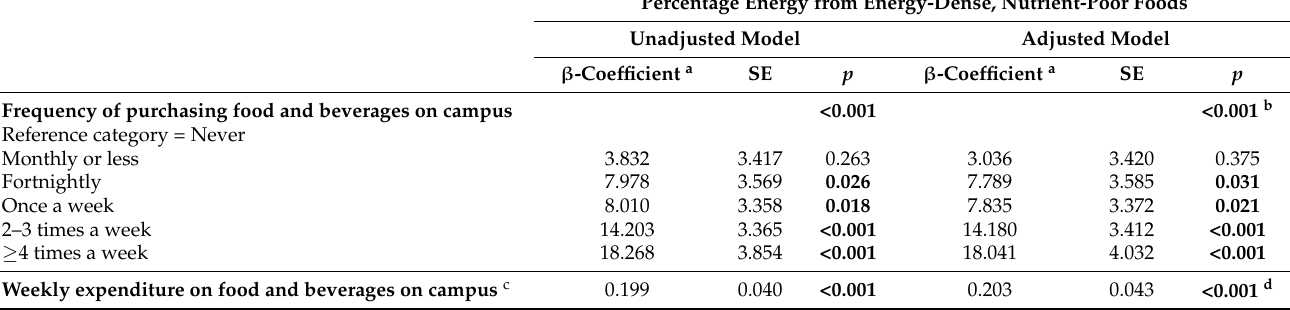
Table 4. Linear regression results of on-campus food purchasing behaviour with energy-dense, nutrient-poor food intake in an Australian university student sample ( n = 362)